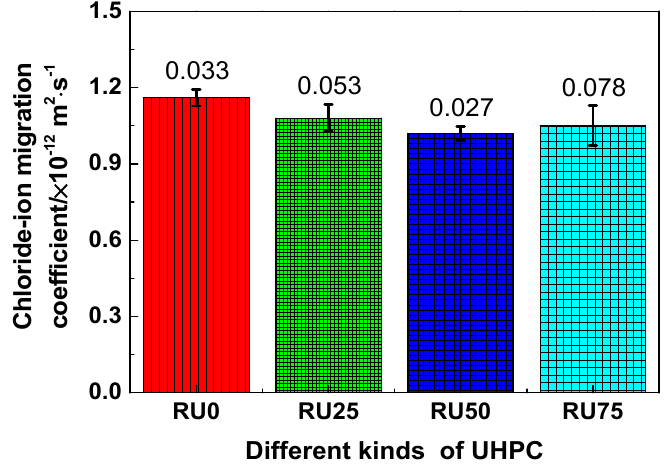
Figure 9. The chloride-ion migration coefficient of RS-UHPC with different contents of GO.